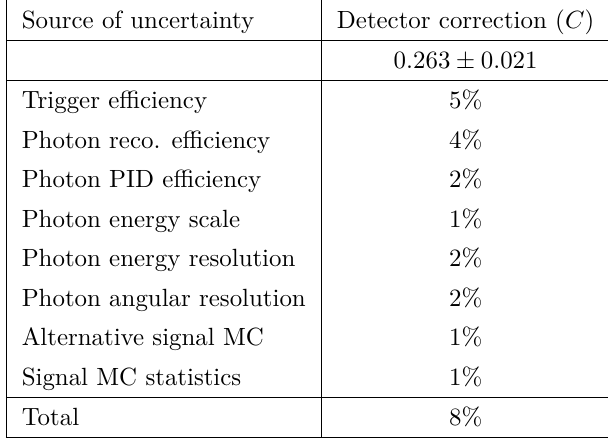
Table 1 . The detector correction factor, C , and its uncertainties for the integrated fiducial cross- section measurement. The second row lists the numerical value of C together with the total uncer- tainty. The total uncertainty on C is a quadratic sum of systematic and statistical